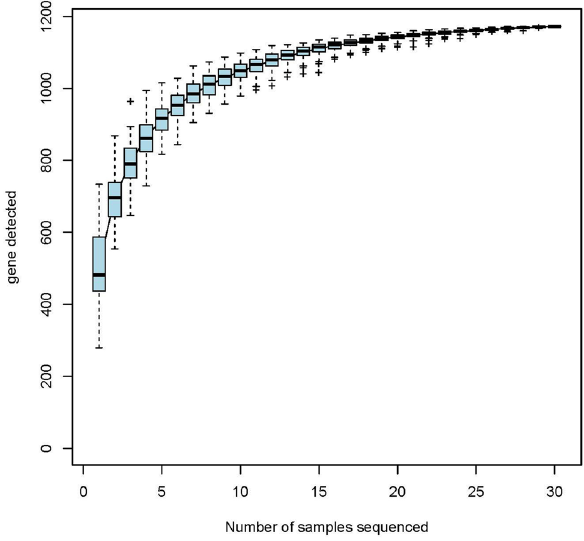
Figure 9. Species accumulation curves. Abscissa sample size ordinate OTU number after sampling.